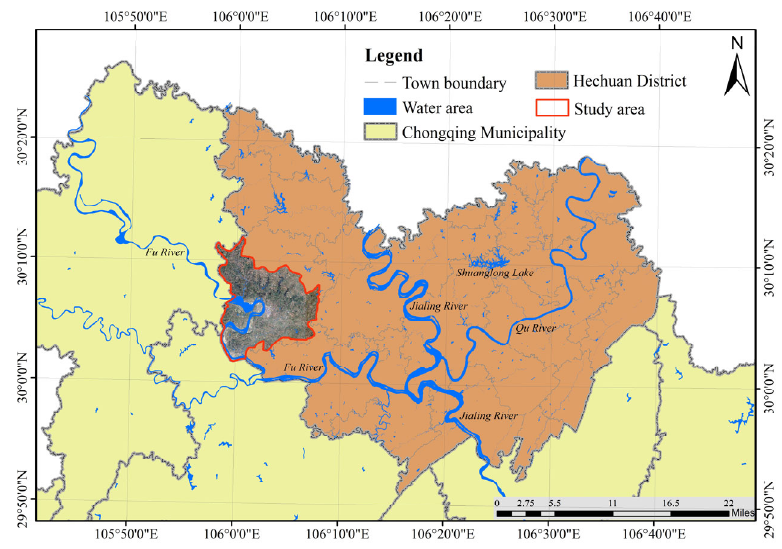
Figure 2. The study area.